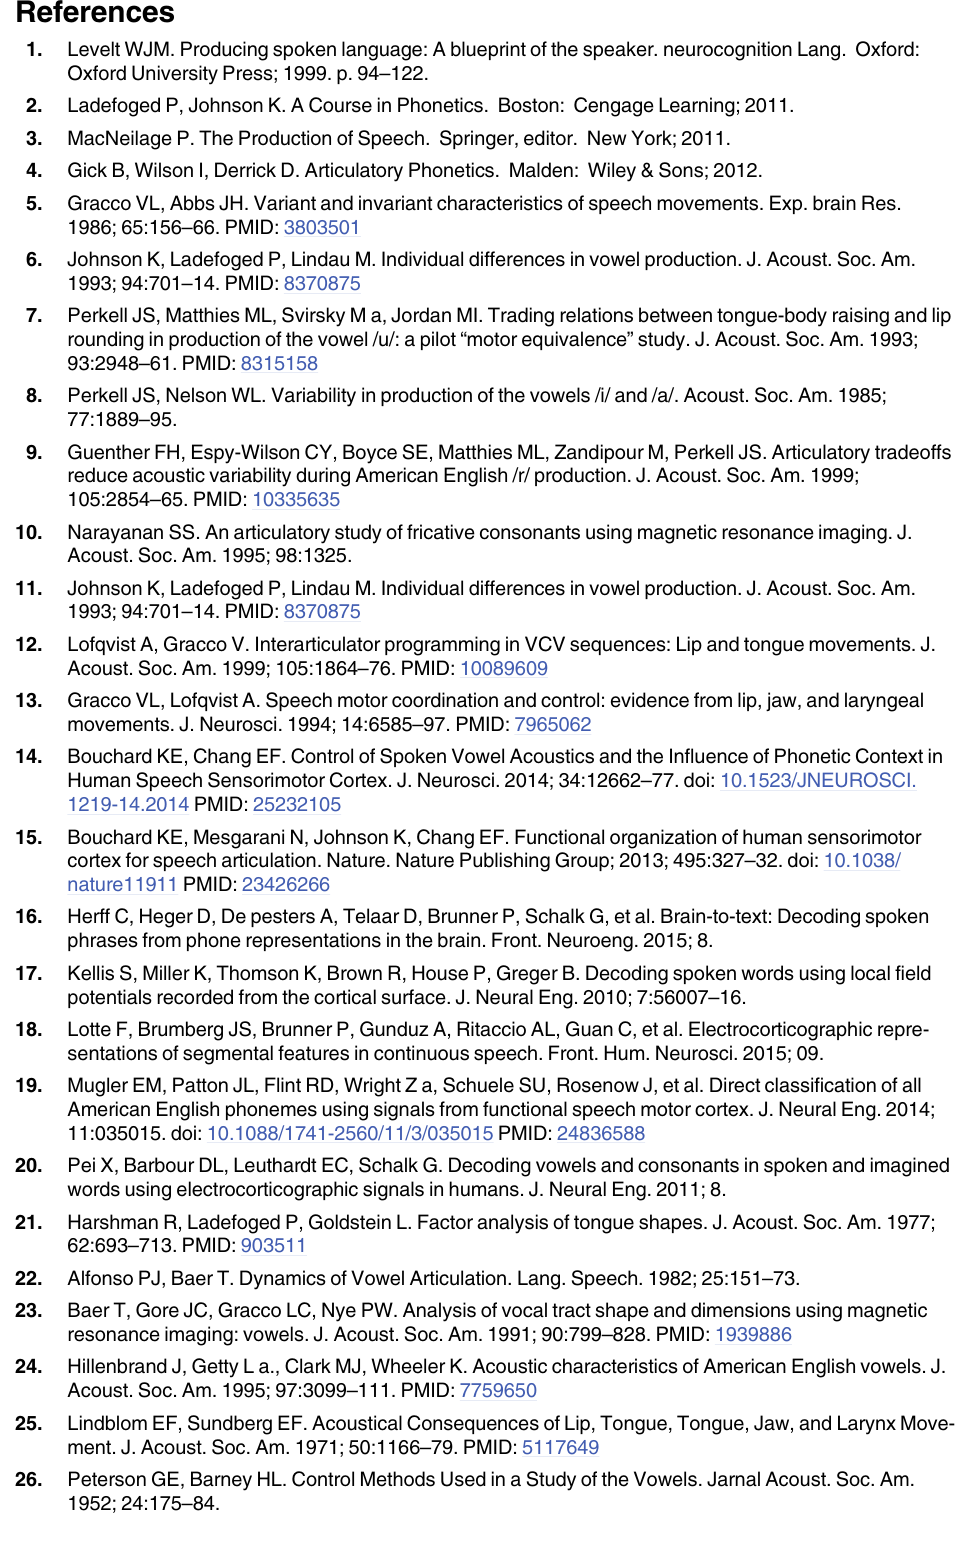
PLOS ONE | DOI:10.1371/journal.pone.0151327 March 28,